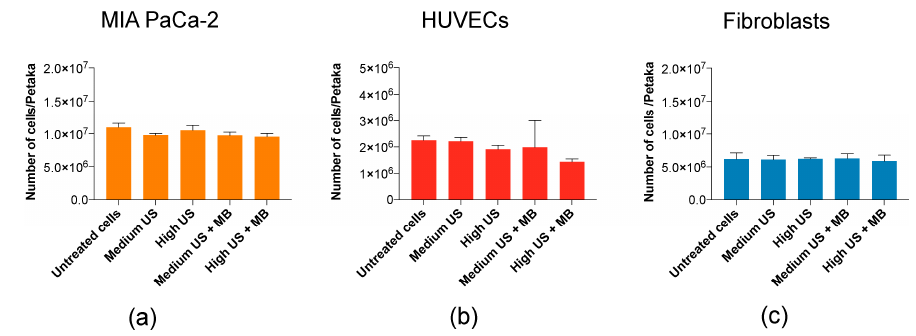
Figure 3. Cell count immediately (0 h) after sonoporation. Cell count (0 h) indicated no mechanical 3 destruction of cells in ( a ) MIA PaCa-2 and ( c ) fibroblasts, while a minor and nonsignificant reduction was observed in ( b ) HUVECs. Mean ± SEM.